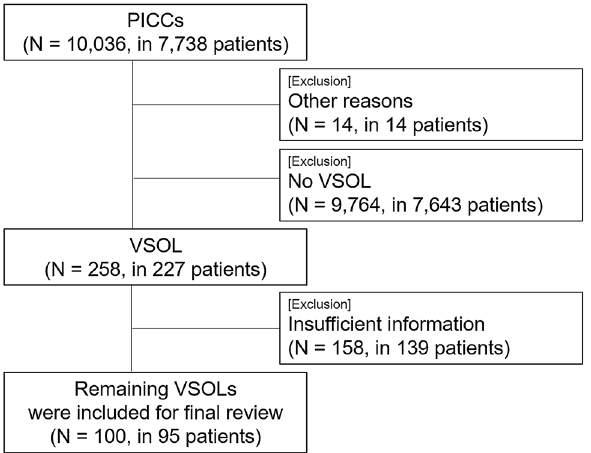
Figure 1. Flow diagram showing patient selection for analysis. PICC peripherally inserted central catheter, VSOL venous steno-occlusive lesion.